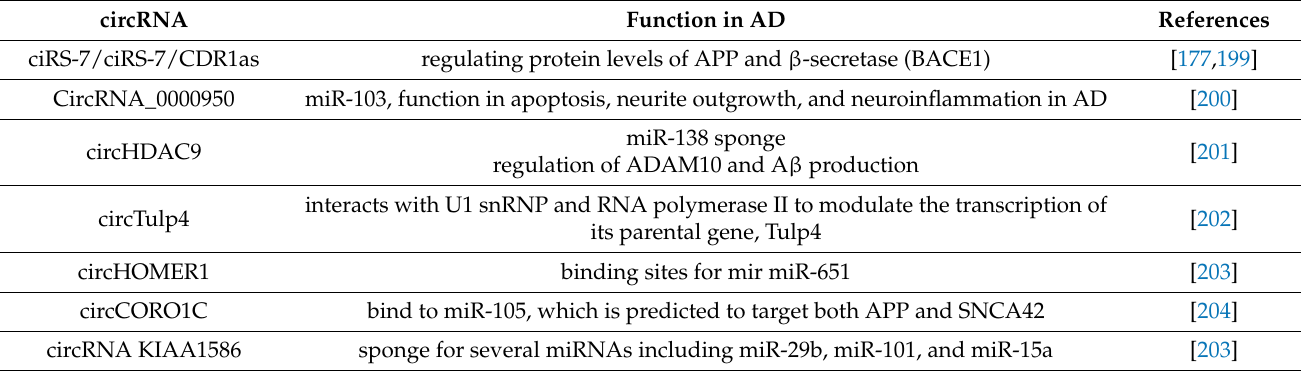
Table 2. circRNAs with known function in